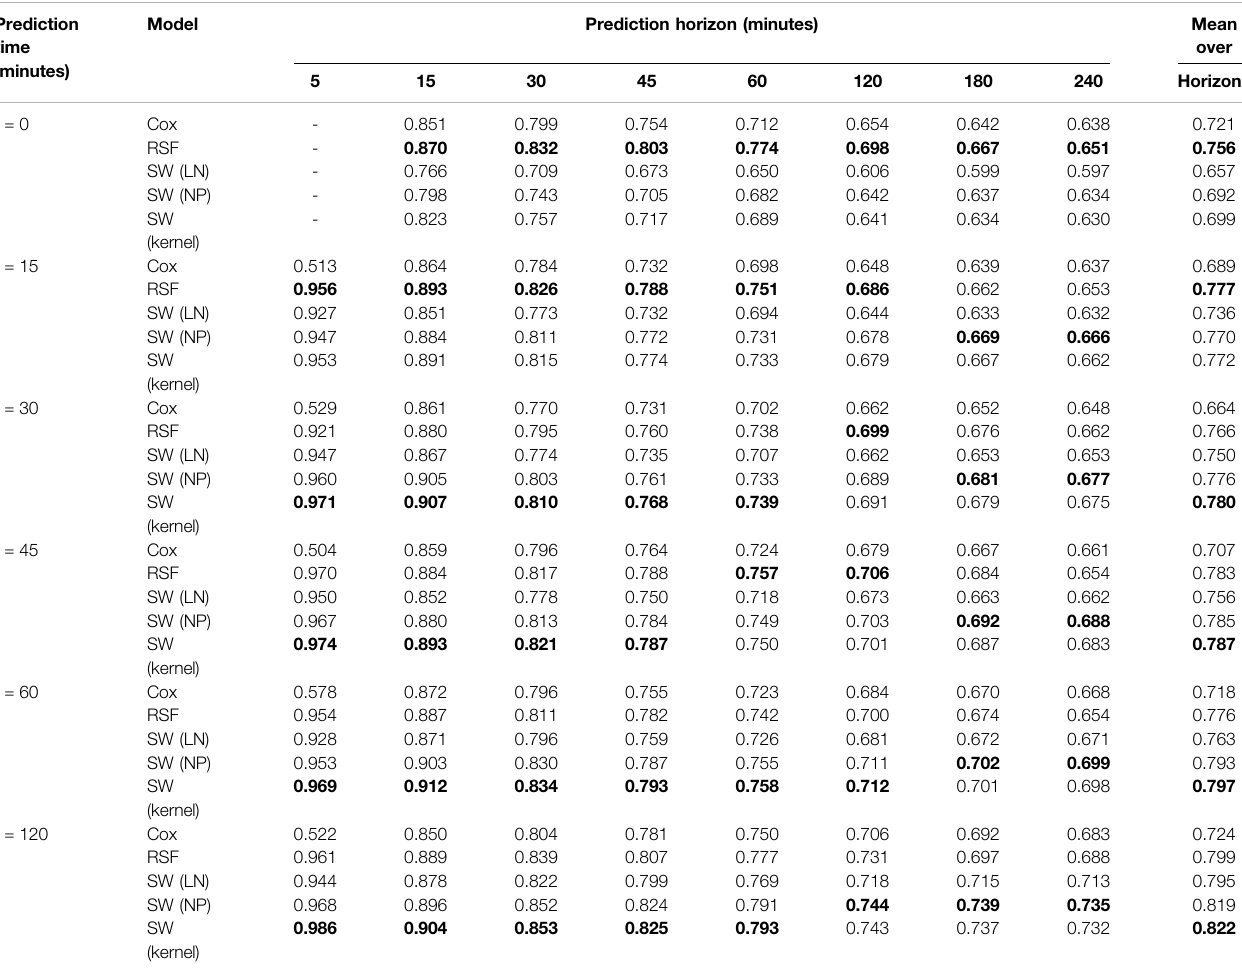
Bold values indicates optimal achieved